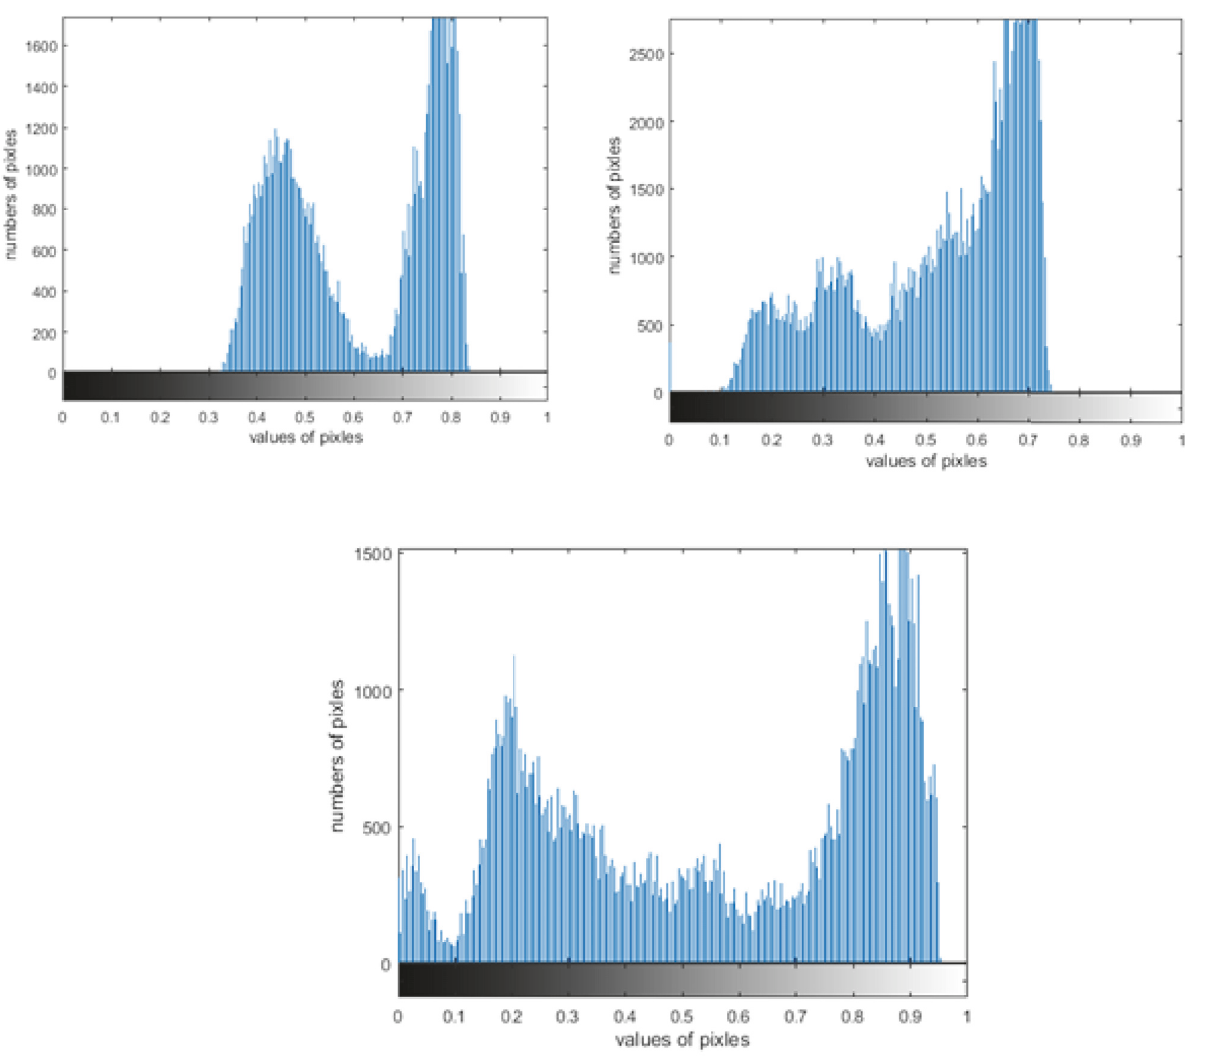
Figure 6: Histogram of dark channel values with obvious light color